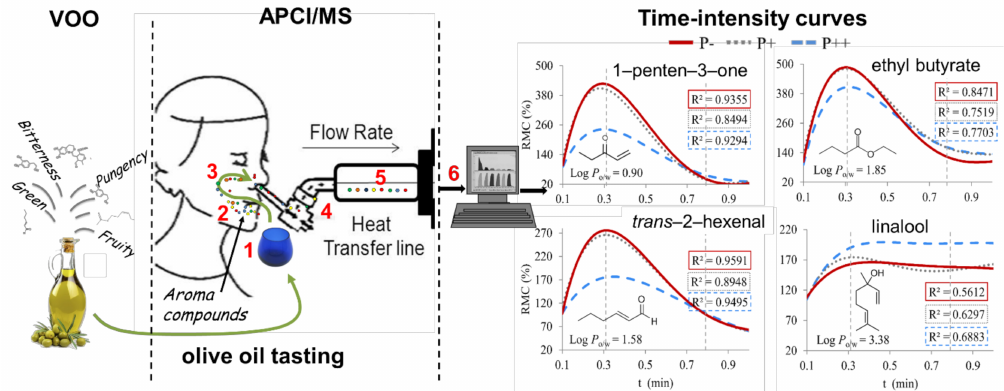
Figure 4. The principle of in vivo study by APCI/MS analysis of the aroma release (time-intensity) in mouth. Legend: (1) VOO aspiration in mouth (without ortho-nasal route), (2) VOO odorants interaction with saliva in the oral cavity, (3) retro- nasal route (aroma after interaction with saliva), (4) aroma expulsion, (5) transfer line, (6) APCI/MS mass spectrometer with registration of time-intensity curves for extra virgin olive oil aroma compounds. P − = VOO without phenolic compounds, P+ = with 354 mg kg − 1 of phenolic compounds, P++ = with 593 mg kg − 1 of phenolic compounds (adapted from Genovese and co-workers